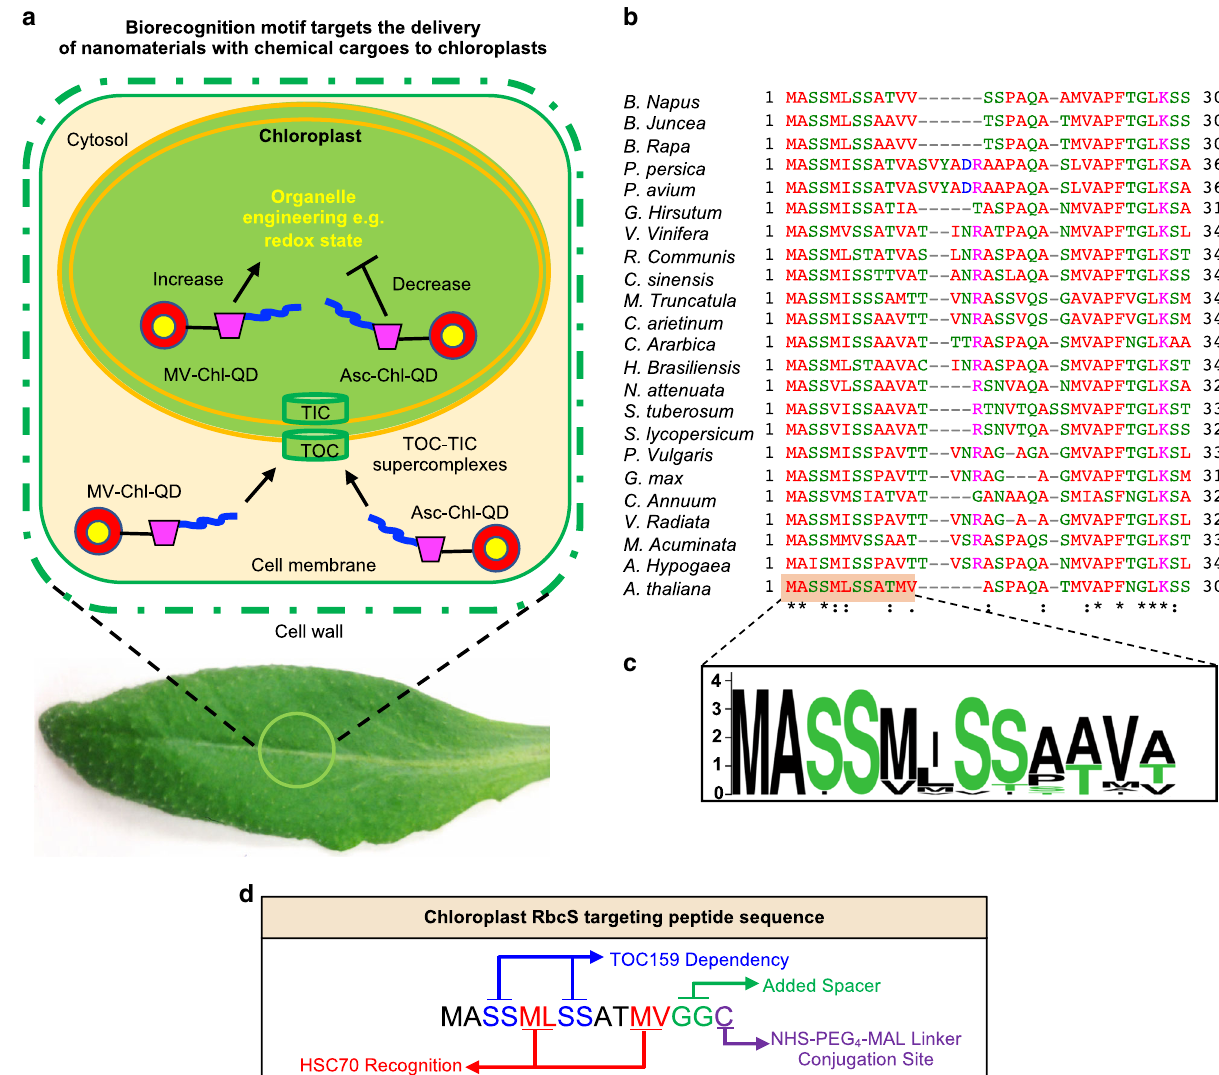
Fig. 1 Targeted delivery of nanomaterials with chemical cargoes in plants enabled by a biorecognition motif. a Quantum dots coated with a chloroplast guiding peptide (in blue) and a β -cyclodextrin ( β -CD) molecular basket (in magenta) enable loading of methyl viologen (MV-Chl-QD) or ascorbic acid (Asc-Chl-QD) and targeted modi fi cation of the redox status of chloroplasts in planta. The Rubisco small subunit (RbcS) targeting peptide is designed to bind to the translocon supercomplex on the chloroplast outer membrane (TOC). b Multiple sequence alignment analysis (Clustal Omega) of RbcS 1 A chloroplast transit peptide sequences in common dicot crops and Arabidopsis thaliana plants. Asterisk indicates the identical amino acids among all the aligned sequences. Colon and dot indicate conserved substitutions in which an amino acid is replaced by another one with similar properties. Empty space represents a non-conserved substitution. Dash lines are introduced for optimal alignment and maximum similarity between all compared sequences. c Frequency logo plot of RbcS 1 A targeting peptide consensus sequence across selected dicot species. A score of 4 on y -axis means 100% conserved. d Rational design of chloroplast guiding peptide based on RbcS peptide biorecognition motif for nanoparticle targeting and translocation across chloroplast membranes. The chloroplast targeting peptide includes recognition sites for chloroplast import machinery by TOC, a cysteine residue at the C-terminus for conjugation with NHS-PEG 4 -MAL linker, and two glycine (G) amino acids as spacers and for increasing the peptide